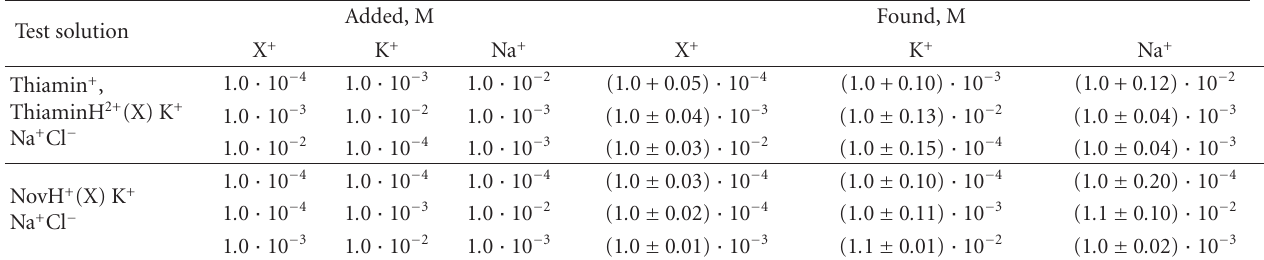
Table 4: The actual and measured values of the analyte concentrations for some test solutions ThiaminCl + KCl + NaCl, NovHCl + KCl + NaCl.